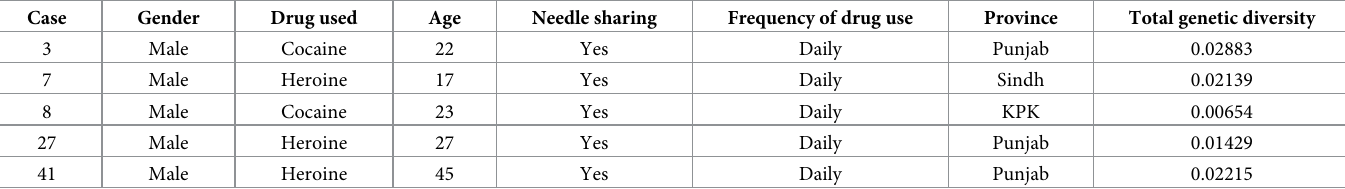
Table 2. Properties of members of the transmission